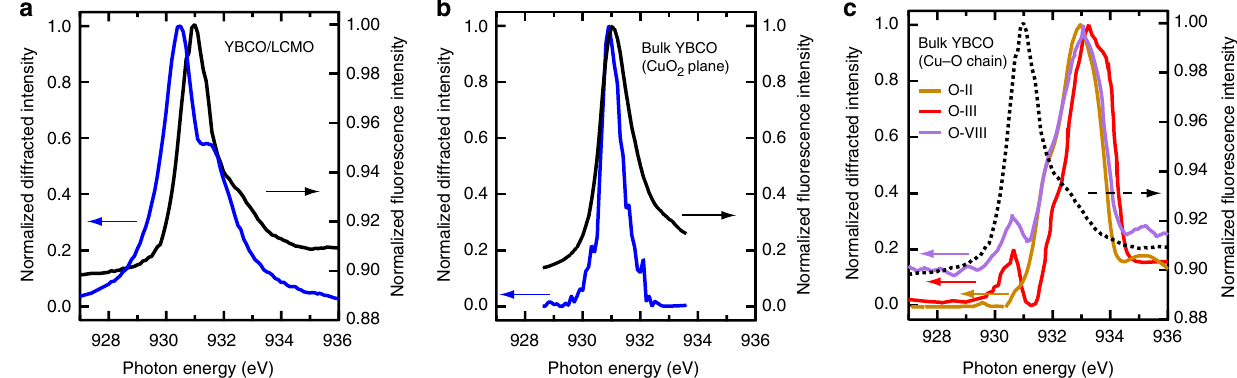
Figure 4 | Comparison on the resonance profile for various orders. ( a ) Photon energy dependence of the diffracted intensity (normalized to the maximum) at ( (cid:2) 0.245, 0, 1.38) associated with the electronic supermodulation (resonance profile; blue curve), in comparison with that of the fluorescence (X-ray absorption spectrum; black), measured on sample #1 at 50K. ( b ) Resonance profile of the period-3 charge order and X-ray absorption spectrum in a bulk YBCO sample, reproduced from ref. 15. ( c ) Resonance profiles of various oxygen orderings, ortho-II, ortho-III and ortho-VIII, in different bulk YBCO samples, reproduced from refs 15,27. Dashed curve is the X-ray absorption spectrum of sample #1 reproduced as a guide to the eye. Slight energy offsets in the energy axis between different experiments have been corrected by setting the corresponding L 3 absorption peak to the same energy. Note that conditions may vary in different experiments. Although the spectral line shape depends on the actual configuration of the oxygen order and the doping level, a common characteristic of these resonance profiles is that the dominant peak is located at least 2 eV above the absorption edge.